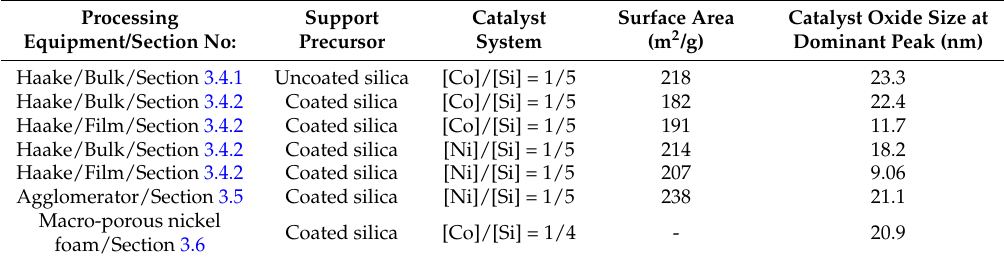
Table 3. Effect of processing conditions on the catalyst size and surface area, after heat treatment at 600 ˝ C (Method-C; Section 3.8) of the samples recovered from the processing equipment (Haake Mixer or GAP-Agglomerator). Film formed between the rotor and mixer wall in the Haake mixer was recovered after the decomposition of the catalyst precursor salt as shown in Figure 4.